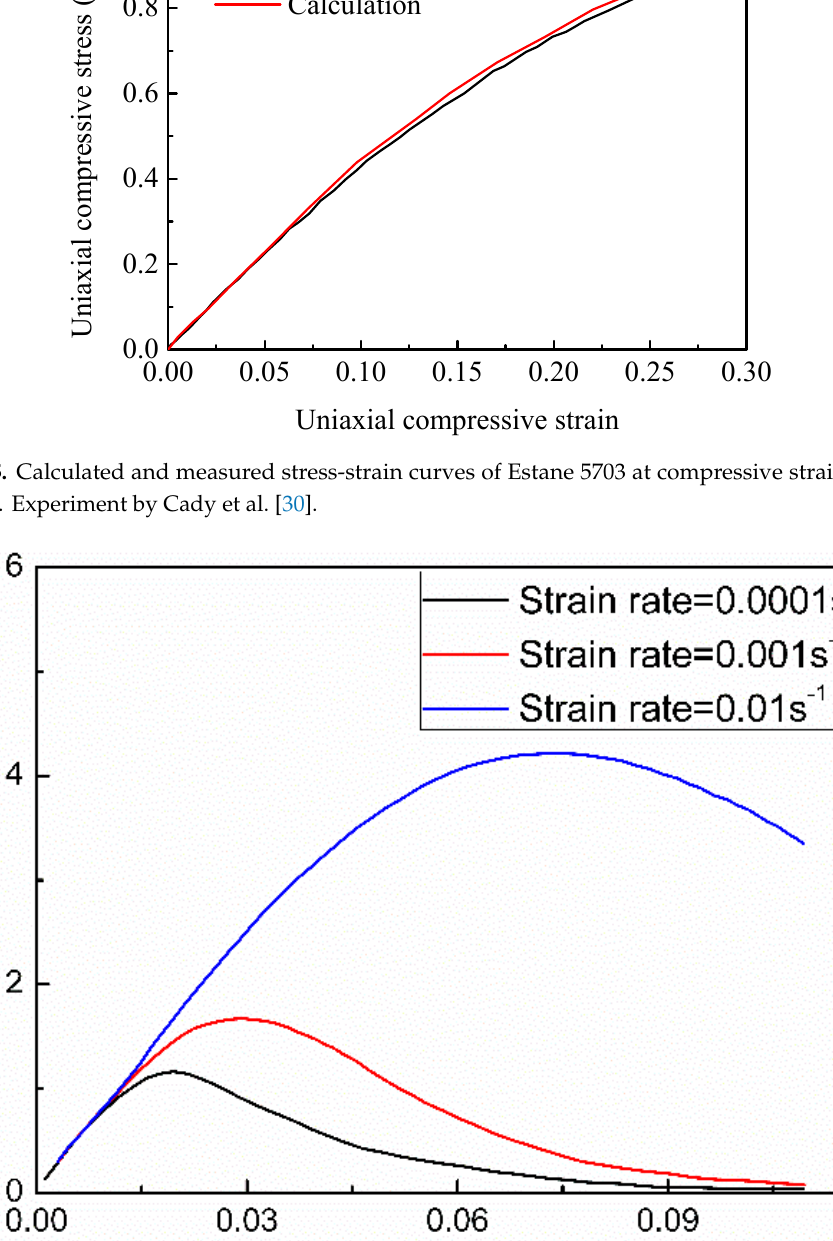
Figure 6. Normal traction–separation curves at different loading rates.